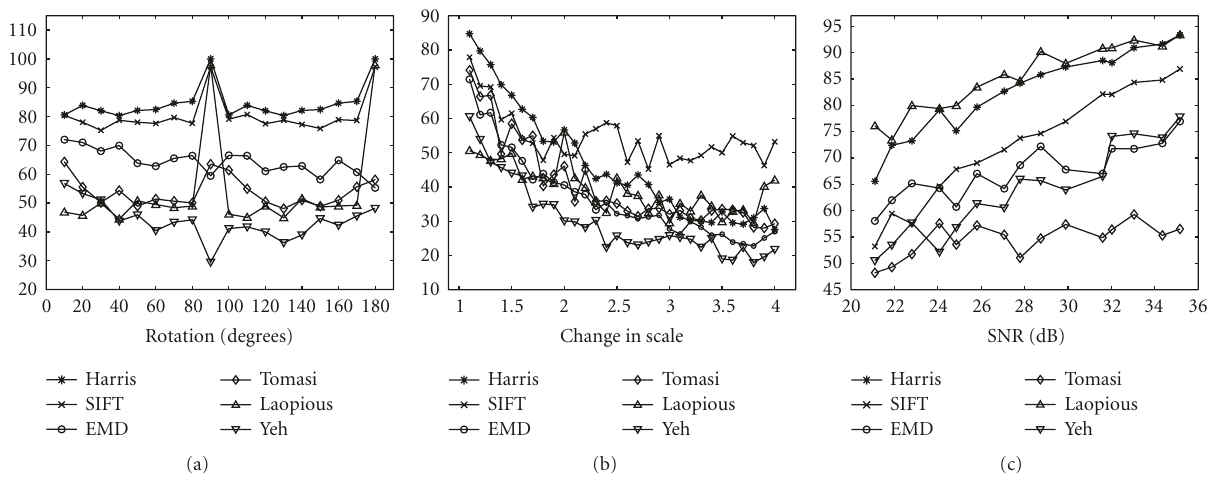
Figure 13: Plot for the repeatability rate as a function of (a) rotation angle, (b) change in scale, and (c) noise level.